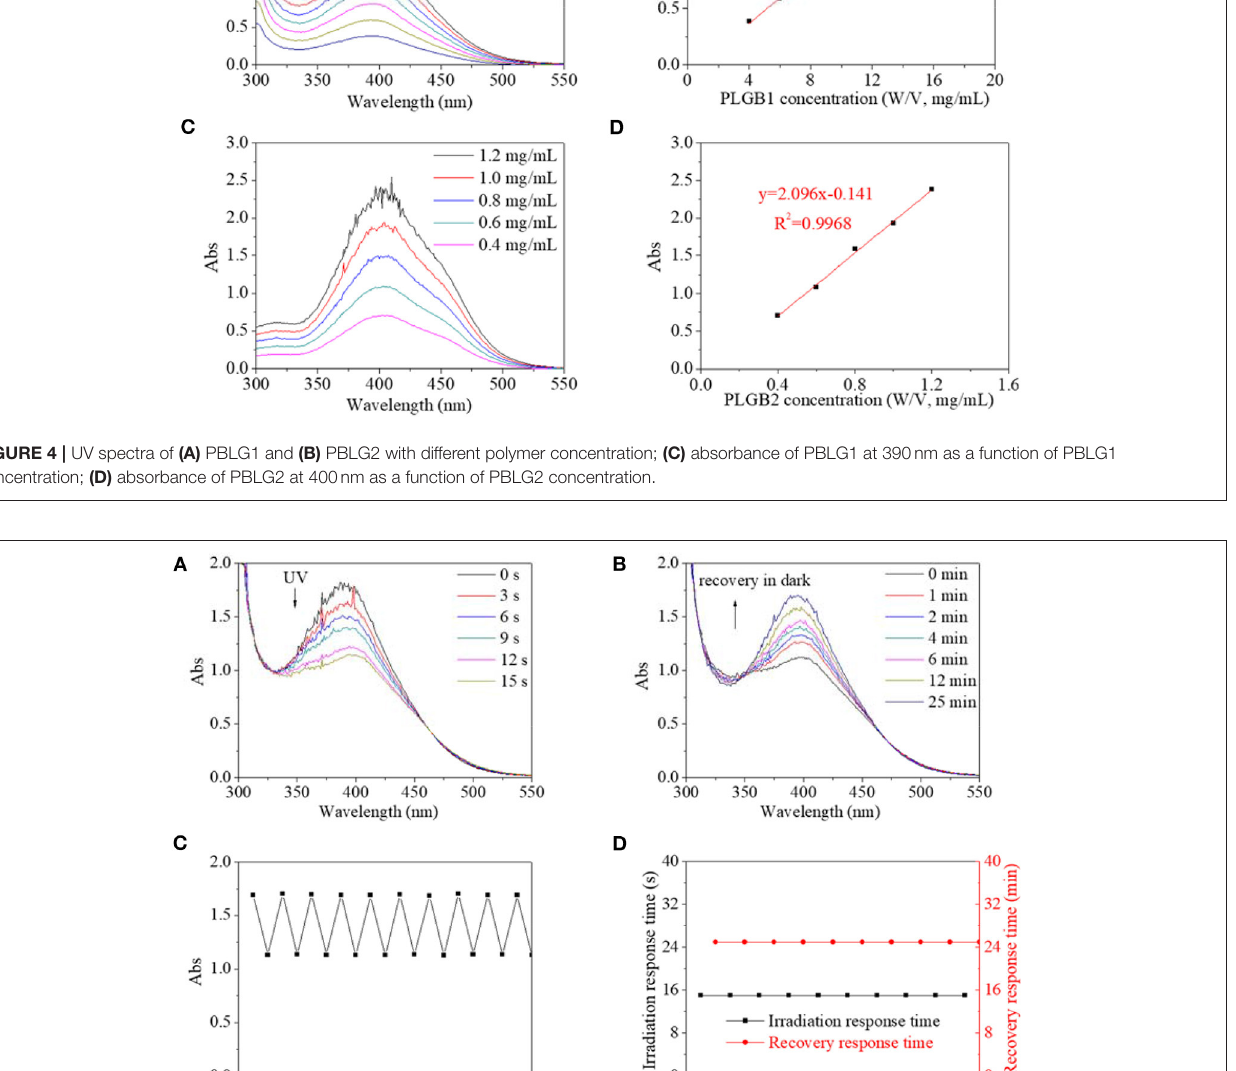
trans-to-cis transformation of PBLG1 according to the above analysis and existing theory for an AZO structure. After irradiation, the decreased absorbances could gradually recover to their original value in the dark within 25 min, which was indicative of the cis-to-trans recovery process ( Figure 5B